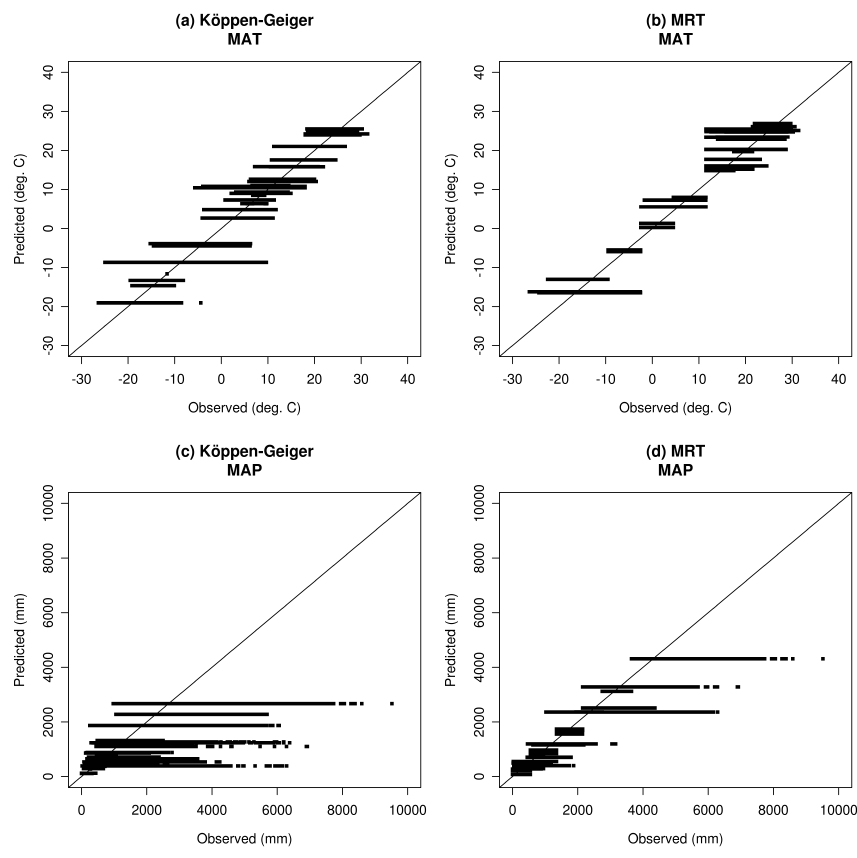
Fig. 9. Scatterplots of observed MAT and MAP versus predicted (a, c) K¨oppen-Geiger and (b, d) MRT class centroids.